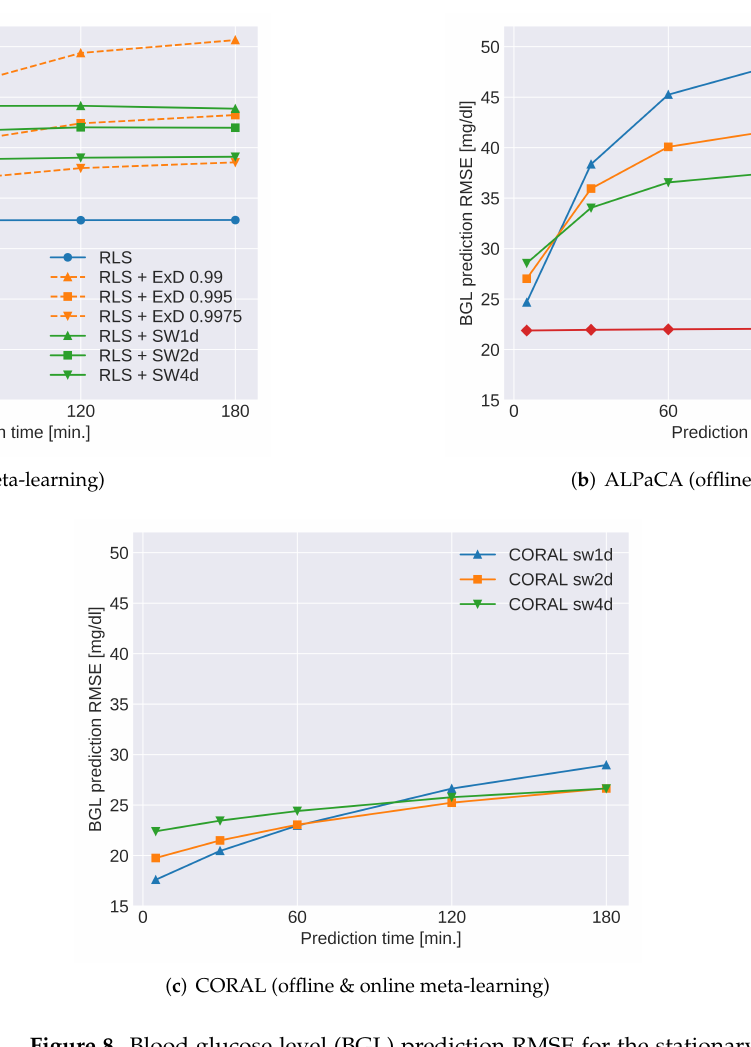
Figure 8. Blood glucose level (BGL) prediction RMSE for the stationary target model (adult#001) with three base models—RLS, ALPaCA and CORAL. The x-axis shows its prediction time in minutes, which shows how far into the future it